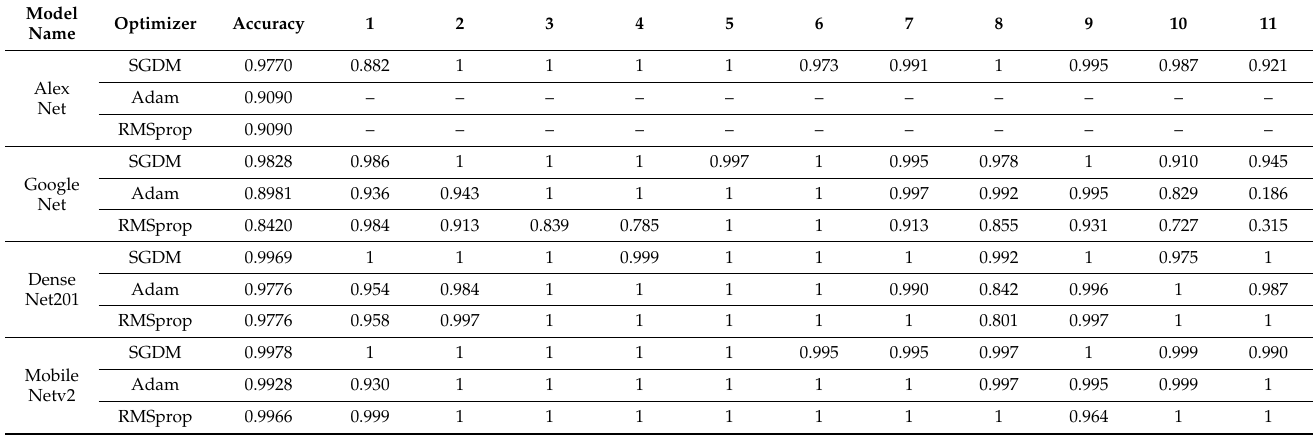
Table 6. BW QR Code Per Printer Identification Result for Each Pretrained CNN